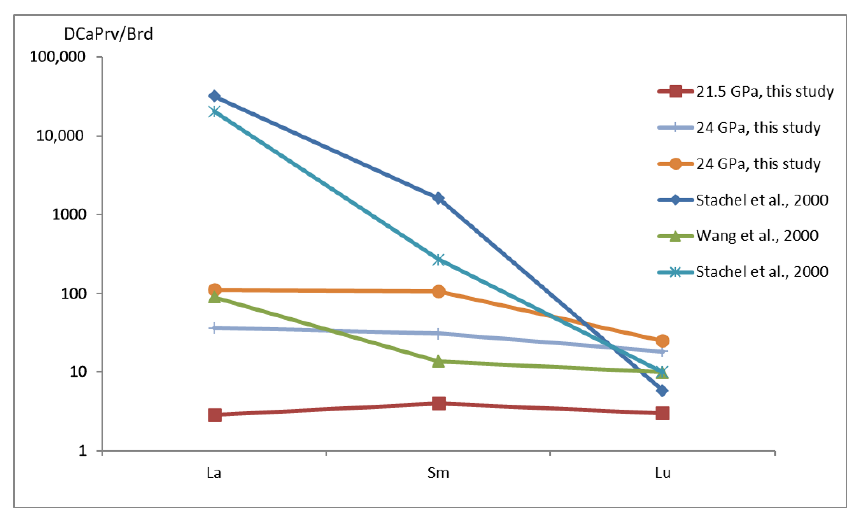
Figure 6. Comparison of REE partition coefficients for bridgmanite and CaSiO 3 -perovskite (Samples 3224-1 and 3214-2, the temperature for all samples is 1600 °C) with the coefficients obtained for the association of Brd + CaPrv from natural diamond [18,19].